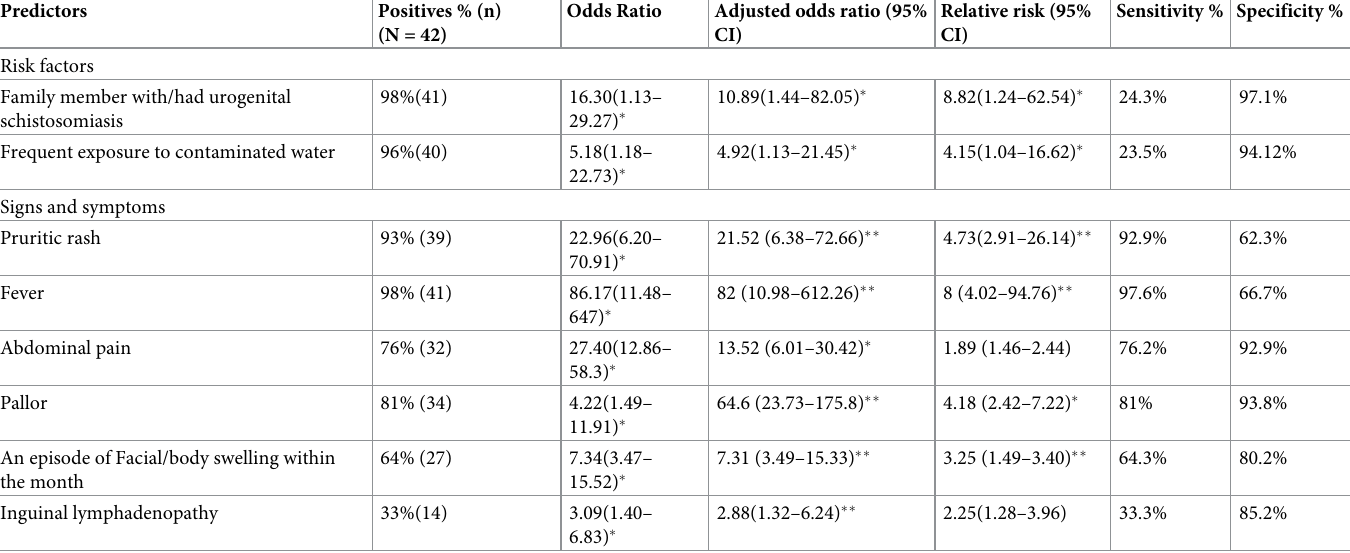
Table 3. New Infection of S . haematobium with Prodromal Signs and Symptoms at